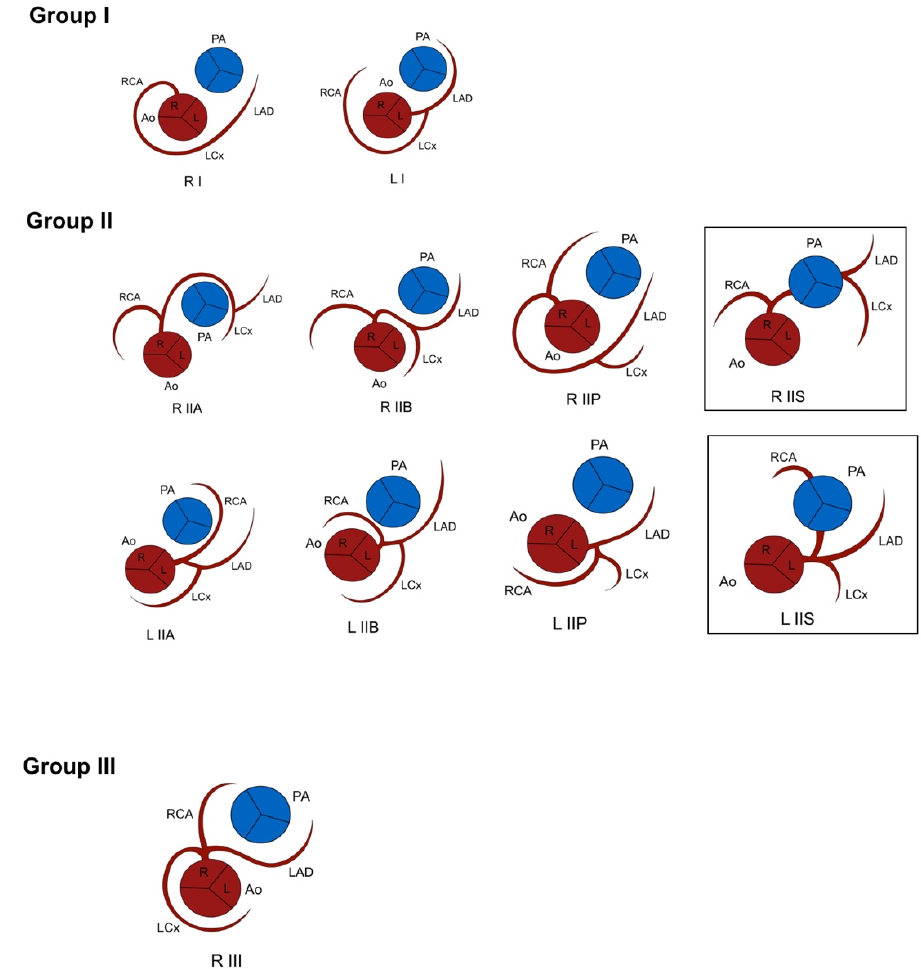
Figure 1. Classification of SCA by Lipton and modified by Yamanaka and Hobbs (marked). Viewed from caudal to cranial, “imaging view”. Ao: Aorta. L: Left sinus of Valsalva. LAD: Left anterior descending artery. LCx: Left circumflex artery. PA: Pulmonary artery. R: Right sinus of Valsalva. RCA: Right coronary artery.